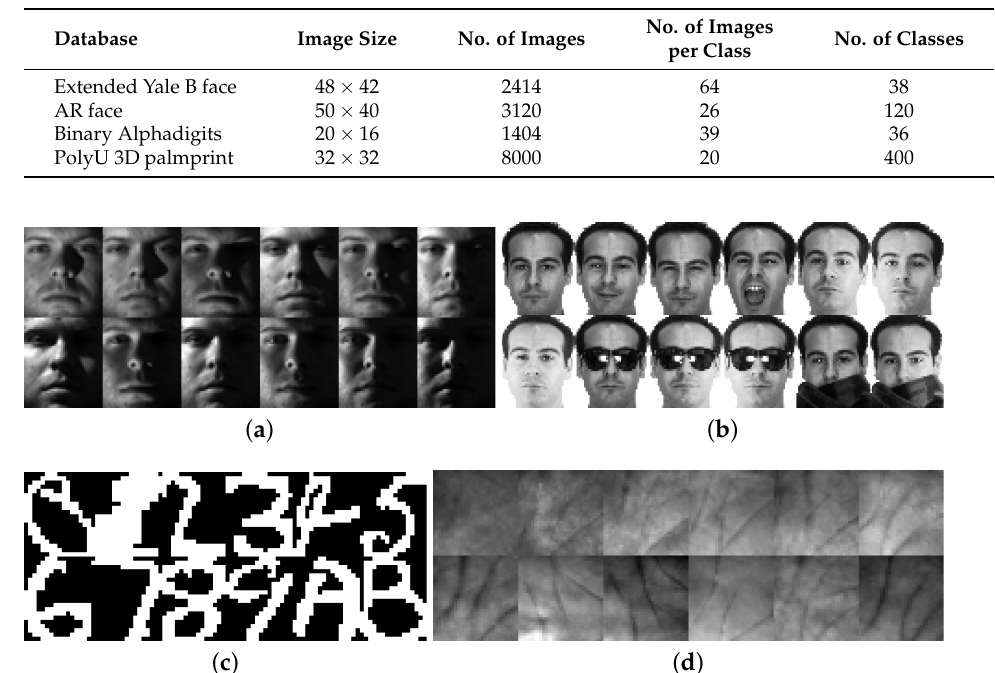
Figure 2. ( a ) Twelve images of the first subject in the Extended Yale B face database. ( b ) The first twelve images of the first subject in the AR face database. ( c ) The first image from twelve different classes in the Binary Alphadigits database. ( d ) The first image from twelve different classes in the PolyU 3D palmprint